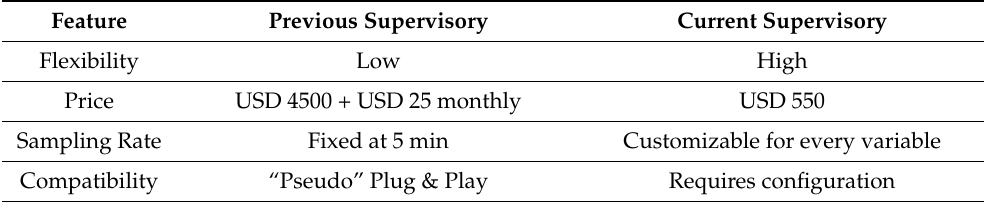
Table 1. Highlights of the comparison between the previous and the current supervisory